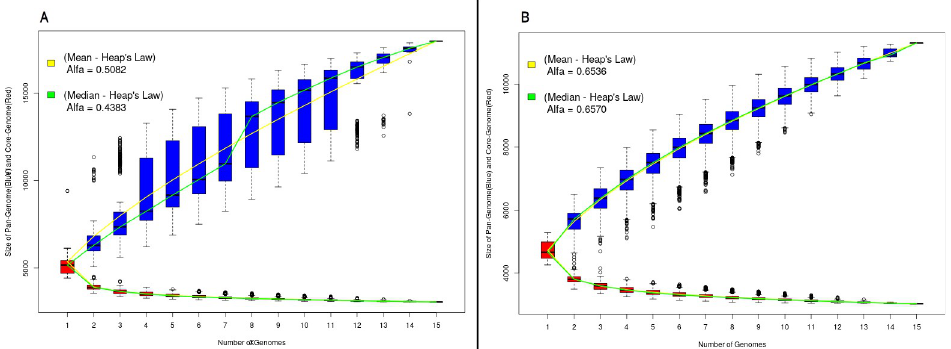
Fig 2. Pangenomic analysis. (A) Pangenome obtained using the PAN2HGENE software. (B) PGAP desktop results. The respective alpha values for the mean and median follow Heap’s law.